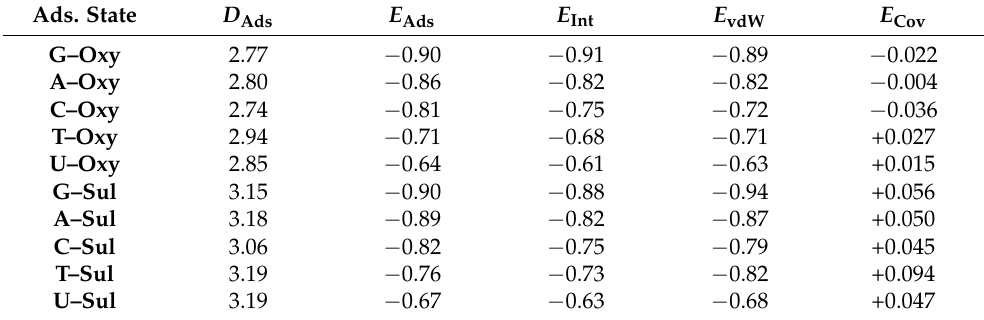
Figure 1. Implicitly, this also could be unveiled by the interaction energy of standard GGA– PBE (covalently) energy term that is less predominant in all molecular orientations at the surfaces. The differences in adsorption energy and adsorption distance show that sensitivity between 1H–MoOS surfaces and G is higher than those of A, T, C, and U, respectively. The adsorption energy values are all negative, demonstrating thermodynamically favorable adsorption characteristics. In Table 1, the moderate binding energies are close to − 1 eV for the nucleobases on either O or S atomic layer sides of the 1H–MoOS monolayer, suggesting that the molecules are physisorbed. Table 1. The DNA (RNA) adsorption distance D Ads (in Å), adsorption energy E Ads , interaction energy E Int , van der Waals energy E vdW , and covalently energy E Cov (All in eV) for dissimilar oxygen (Oxy.) and sulfur (Sul.) layers,